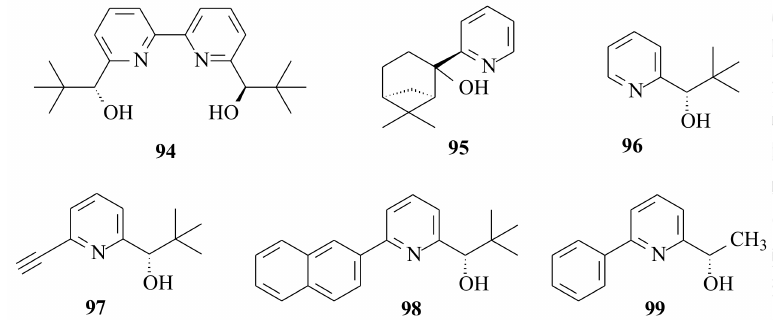
Figure 18. Pyridinyl alcohol compounds used as ligands in enantioselective additions.